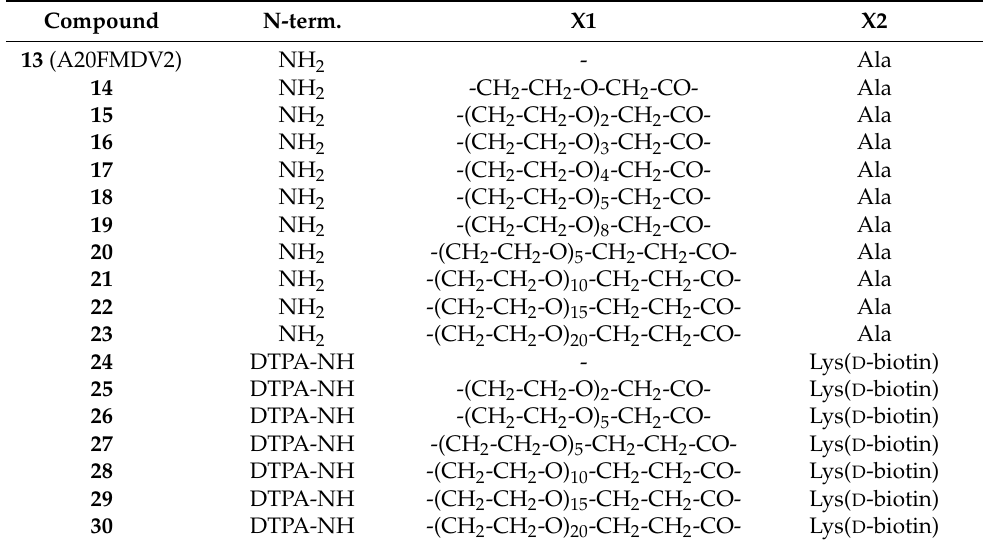
Table 1. Synthesized peptides during the studies: A20FMDV2 ( 13 ), DTPA-[ 2 Ala to Lys( D -biotin]A20FMDV2 ( 24 ) and PEGylated peptide analogues [ N-term ]- X1 -N- X2 -VPNLRGDLQVLAQLVART-OH ( 14 – 23 , 25 – 30 ). Compound